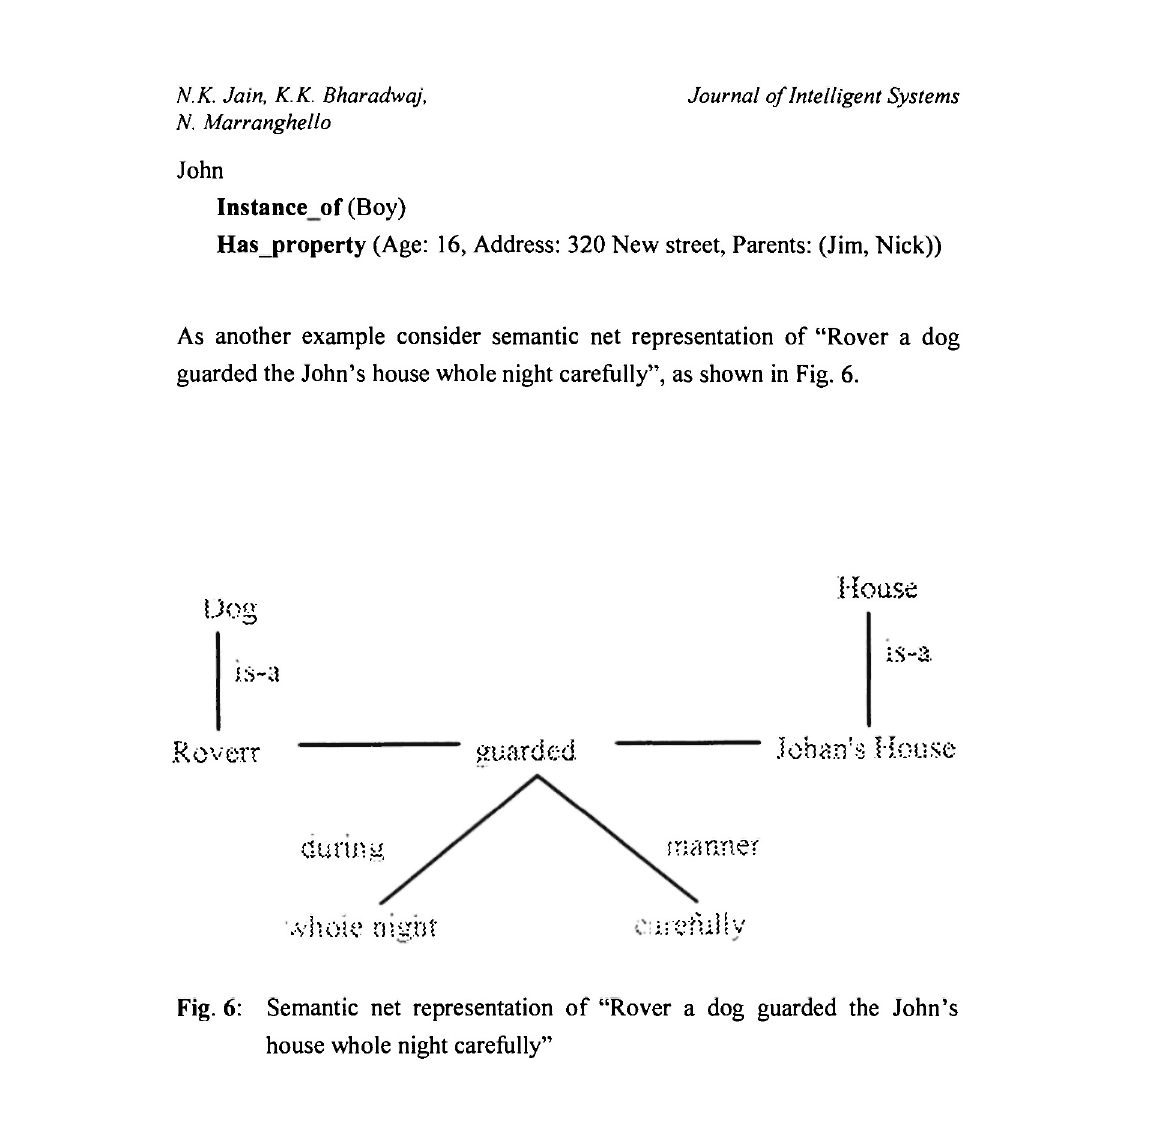
Fig. 6: Semantic net representation of "Rover a dog guarded the John's house whole night